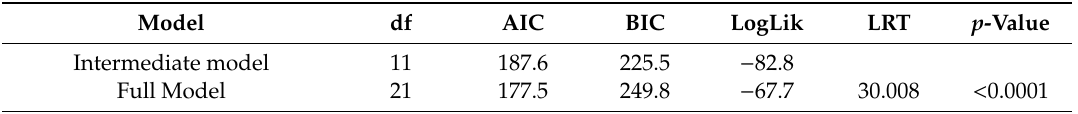
Table 4. Likelihood ratio test between the intermediate model Equation (2) and the full model Equation (3). Model df AIC BIC